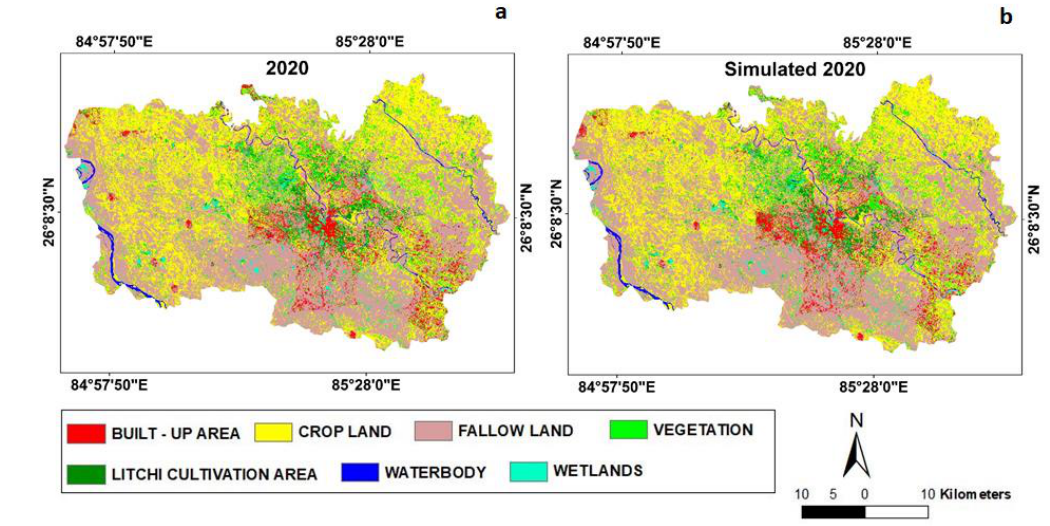
Figure 8. ( a , b ) Actual LULC map of the year 2020 and simulated map of the year 2020. Table 7. Area estimates of predicted LULC in